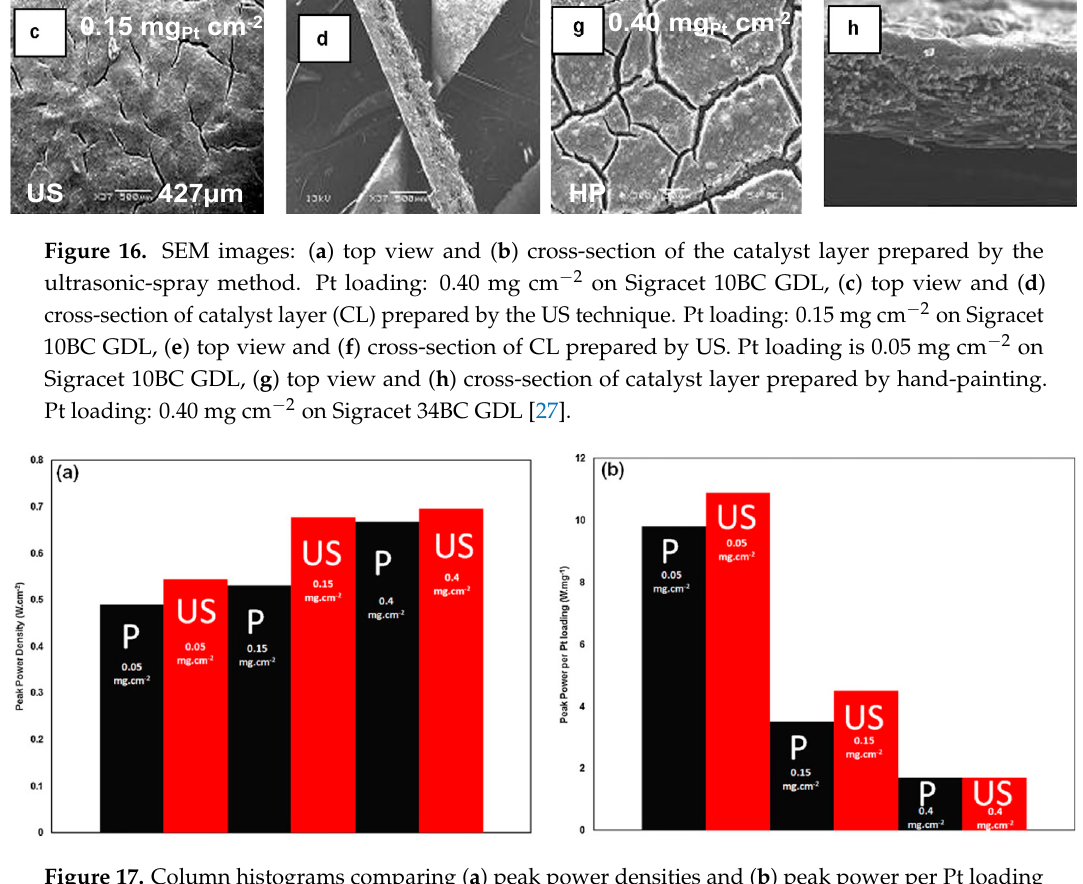
Figure 17. Column histograms comparing ( a ) peak power densities and ( b ) peak power per Pt loading for both hand-painted (P) and ultrasonic-sprayed (US) SGL 10BC GDLs: 0.40 mg cm − 2 , 0.15 mg cm − 2 , 0.05 mg cm − 2 [27].